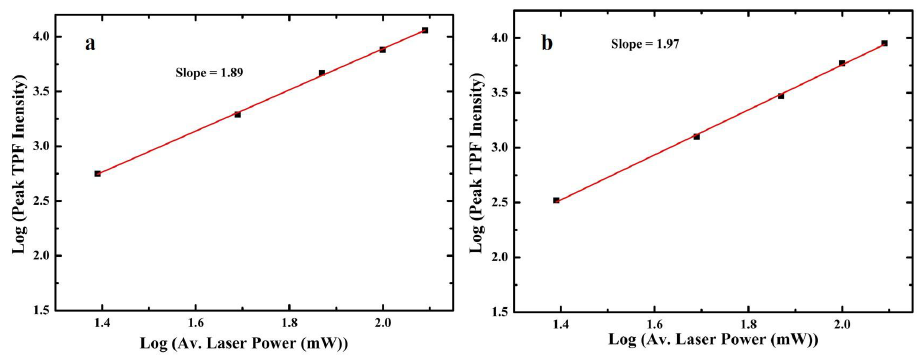
Figure 2. Quadratic dependence of TPF ( a ) for compound 7 and ( b ) for compound 8 .